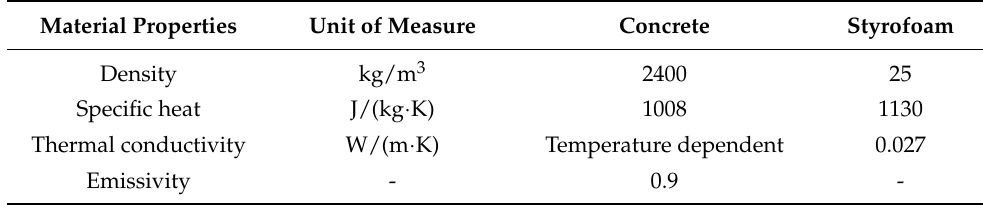
Table 2. Materials properties for the numerical simulation. Material